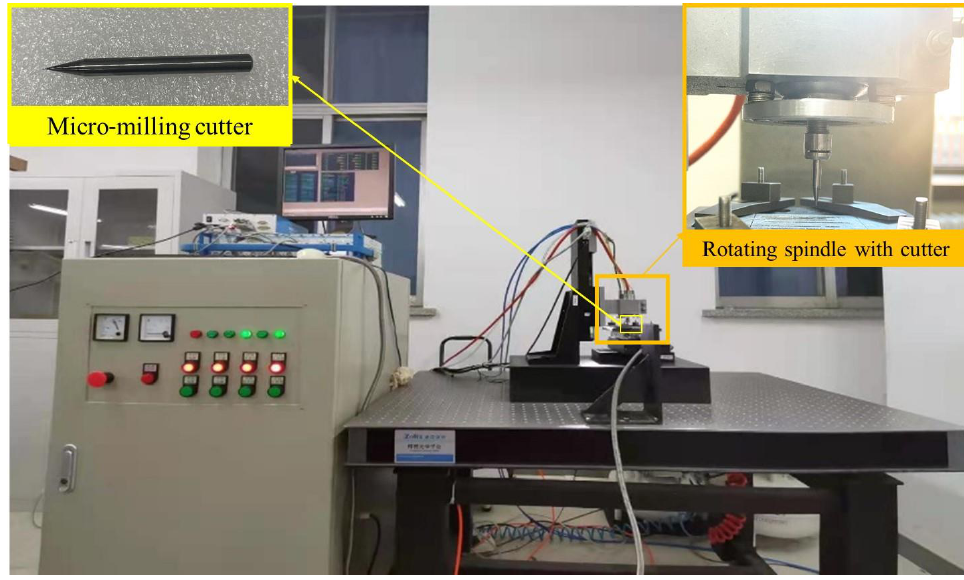
Figure 9. The micro-milling experimental platform. Table 5. The comparison of experimental and simulated reduction rate of the tool diameter.